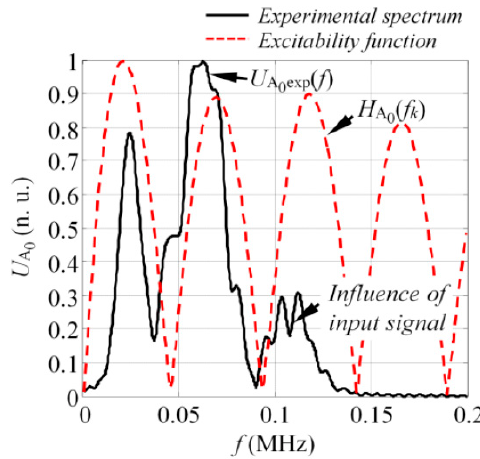
Figure 12. The comparison between the experimental spectrum of the A 0 mode and the analytical excitability function.